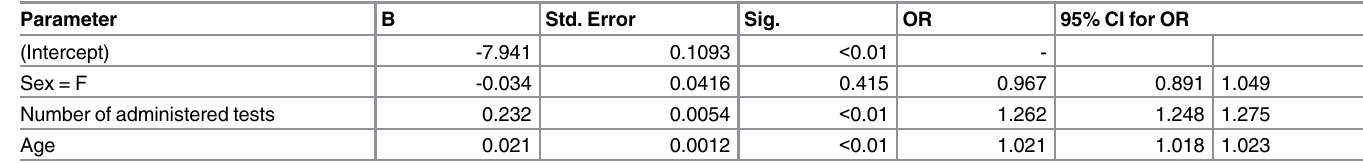
Table 2. A simplistic alternative to the ALaRMS score with comparable accuracy to the adjusted-for-number of administered tests ALaRMS score. Parameter B Std.